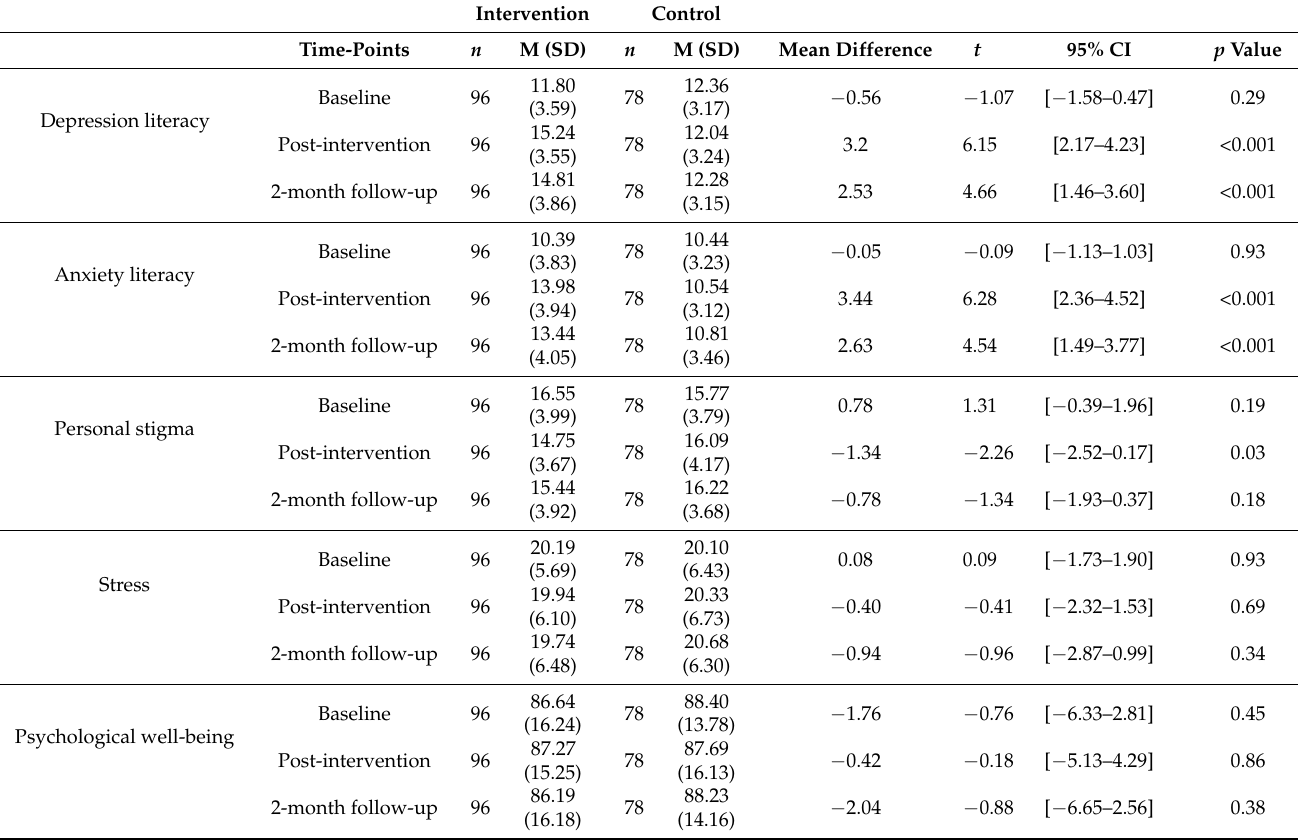
Table 3. Comparisons of depression and anxiety literacy, stigma, psychological well-being, and stress scores between the two